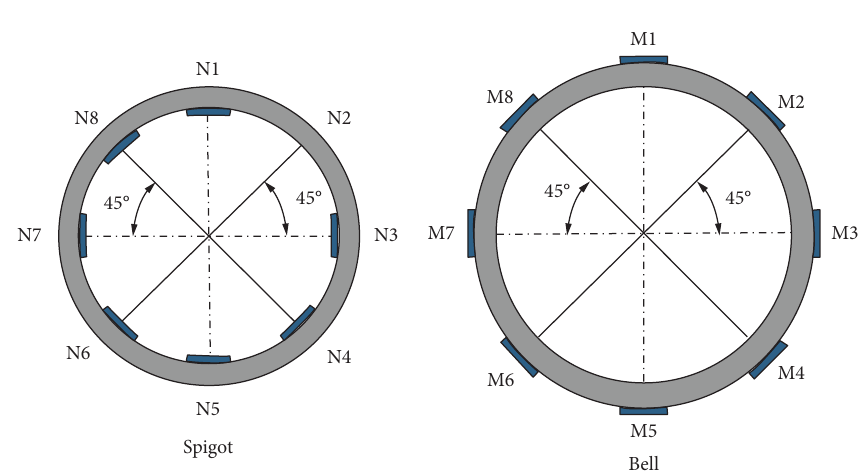
Figure 32: Circumferential sticking position of strain